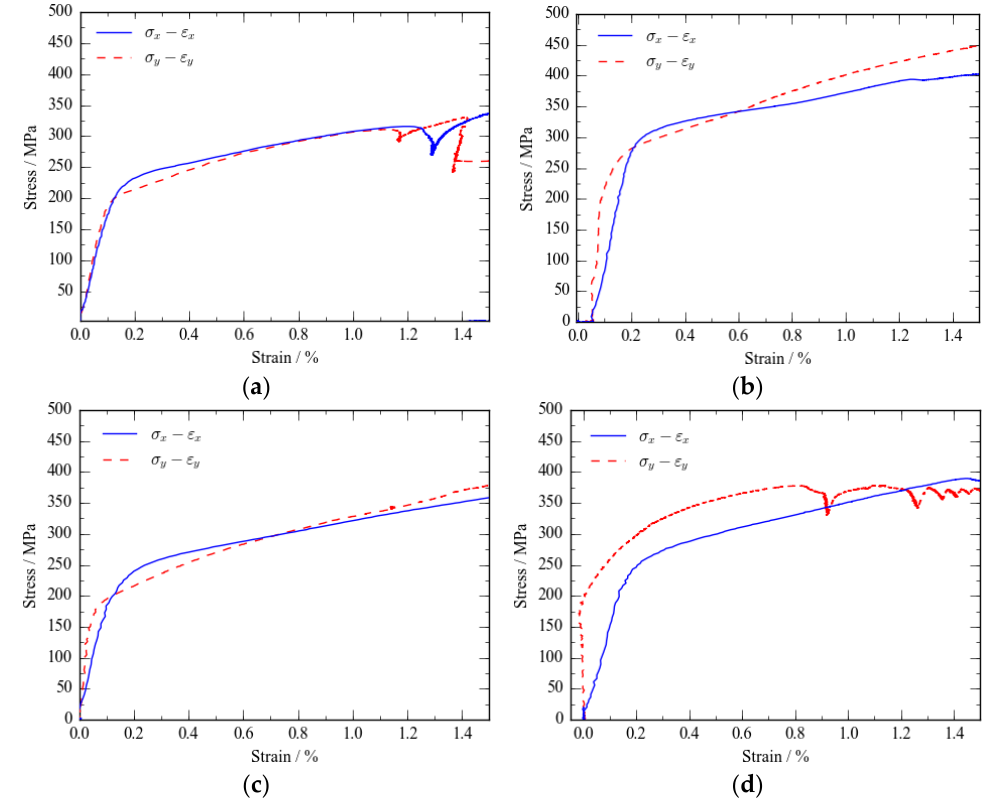
Figure 17. Stress – strain relationship under different displacement ratios (X/Y). ( a ) Displacement ratio of 1:1; ( b ) displacement ratio of 4:3; ( c ) displacement ratio of 2:1; ( d ) displacement ratio of 4:1.